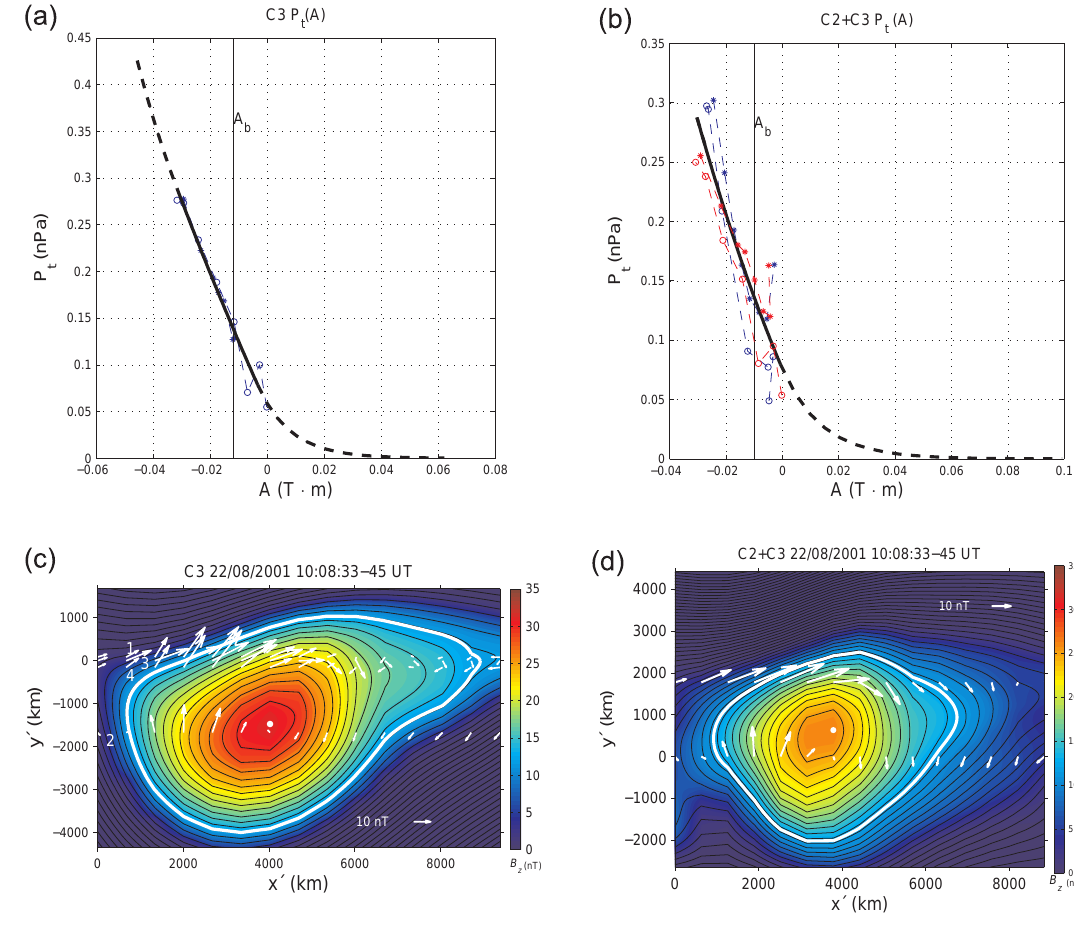
Fig. 2. (a) Single-s/c GS: P t (A) plot for C3 with the 2nd order polynomial fitting function (solid black) with exponential tails (dashed black) used for the right hand side of the GS Eq. (2). Circles and stars represent inbound and outbound measurements, respectively. (b) Multi-s/c GS2: Combined P t (A) plot (red C3, blue C2). (c) GS: Magnetic field map integrated from C3 observations taken as initial values. B z is color coded, pointing out of the paper, and maximizes at the white dot. Black contours are magnetic field lines in the paper plane, the white contour corresponds to the vertical line ( A b ) in Fig. 2a. Arrows indicate observations along each spacecraft trajectory. From top to bottom: C1-C3-C4-C2. The structure propagates toward Earth to the left, positive ˆ y 0 points south of the ecliptic (see also Fig. 3). Grid size: 15 × 91. (d) GS2: Combined magnetic field map from C2 and C3. The arrows are again magnetic field components in the ˆ x 0 − ˆ y 0 (paper) plane along the trajectories of C3 (upper) and C2 (lower). Also note the same scale for the color coded B z as in Fig. 2c. Grid size: 15 ×